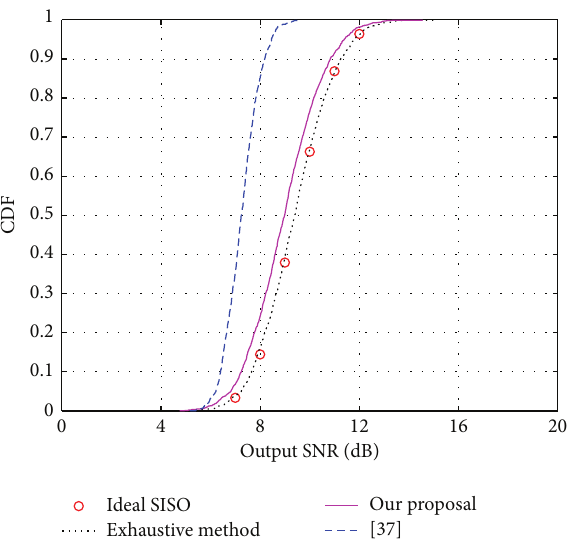
Figure 3: Comparison of simulated and theoretical CDFs.